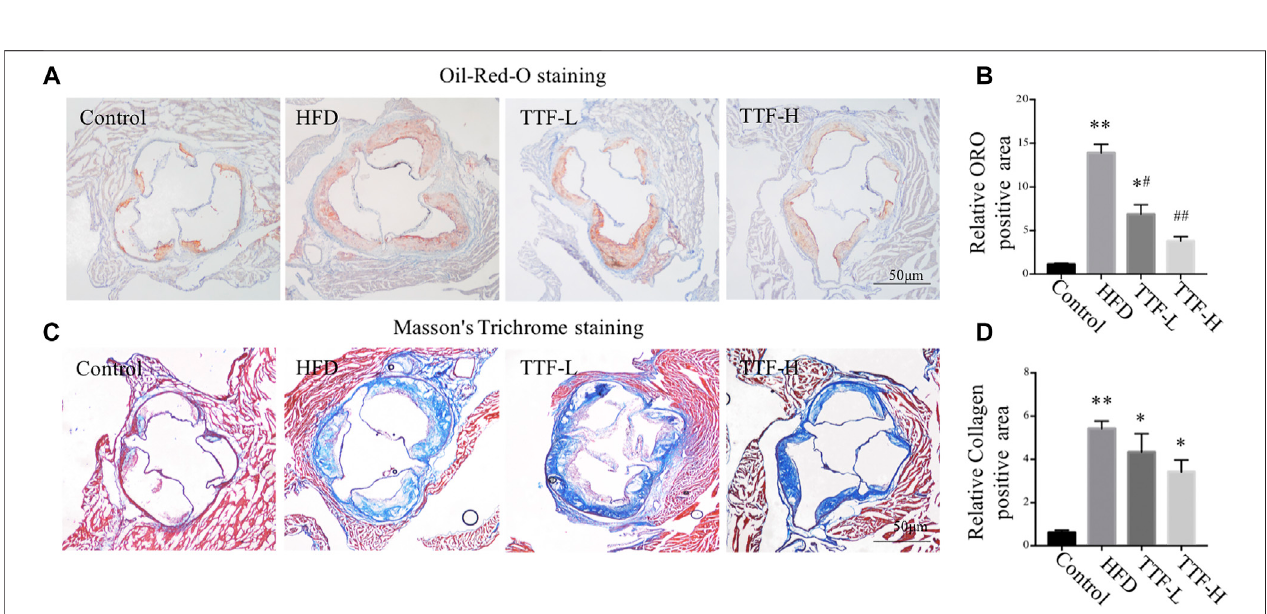
FIGURE 4 | TTF reduces lipid content and increases collagen content in atherosclerotic plaque of ApoE -/- mice. Representative images of (A) Oil-Red-O staining and (B) the quantitative analysisofrelative OROpositivearea. Representative images of (C) Masson ’ sTrichromestainingofaortic sinus and (D) the quantitative analysis of relative collagen positive area. Values are presented as means ± SEM (n (cid:2) 3 per group). * p < 0.05 vs Control group, ** p < 0.01 vs Control group, # p < 0.05 vs HFD group, ## p < 0.01 vs HFD group. Bar (cid:2) 50 μ m.